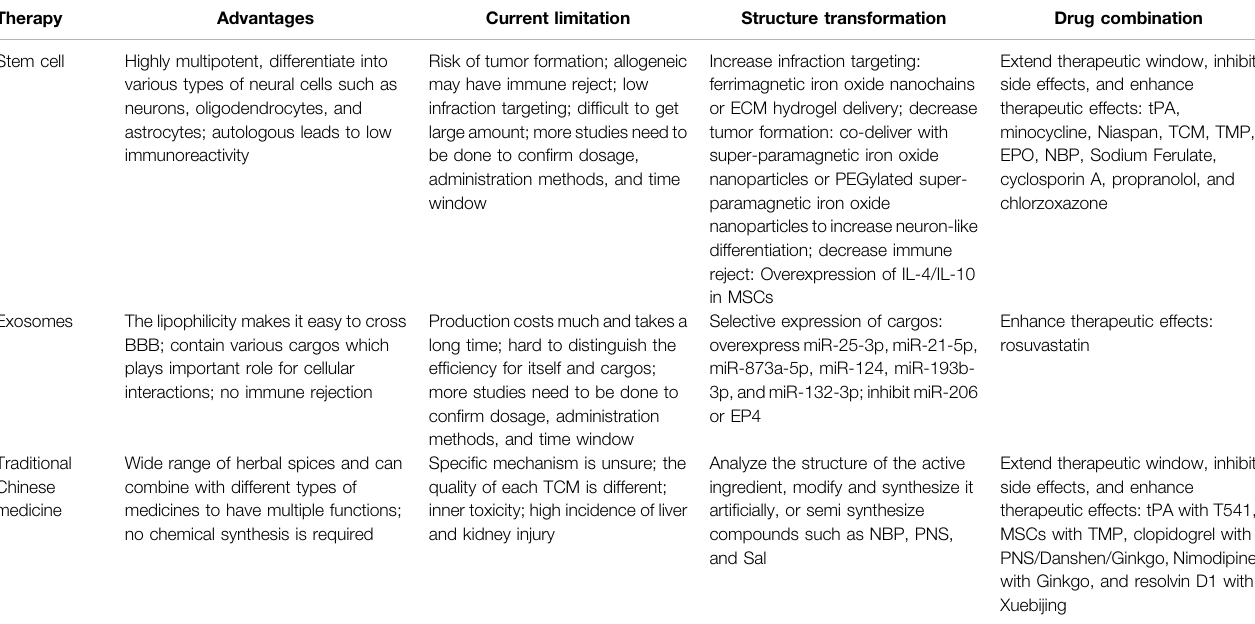
TABLE 1 | The challenge and research progress for therapies of